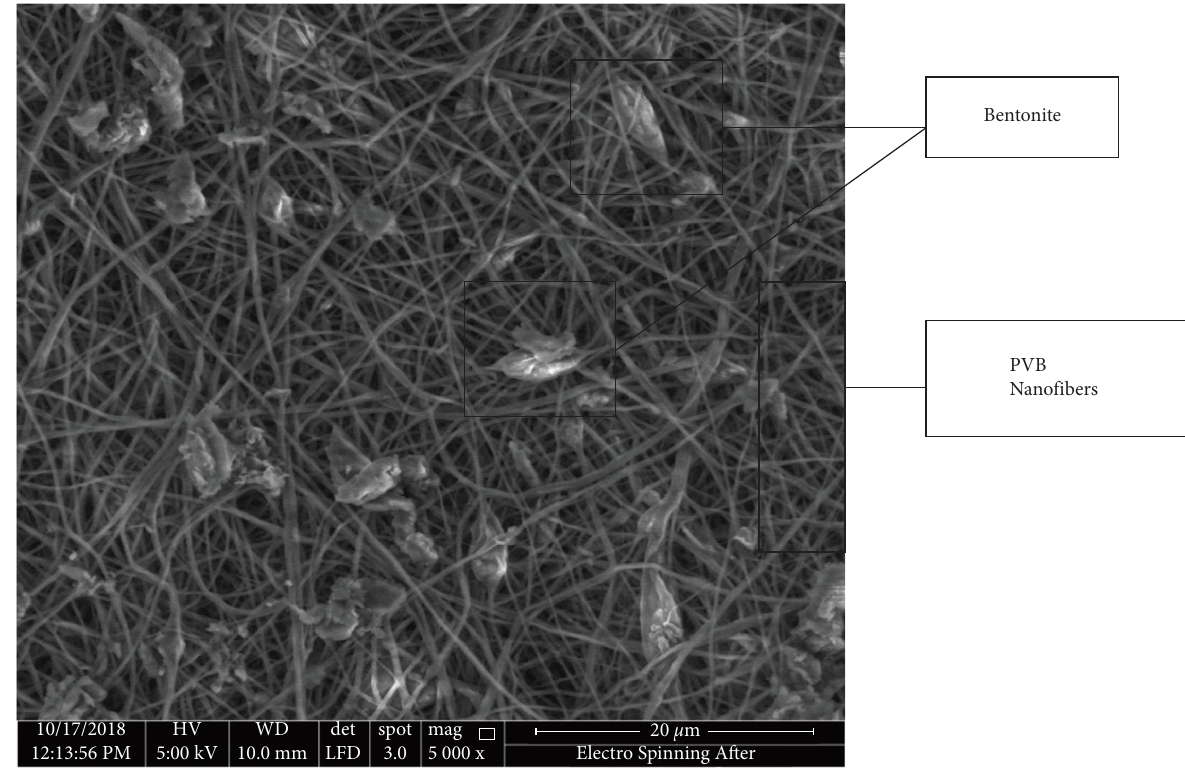
Figure 3: SEM/EDX of PVB/bentonite